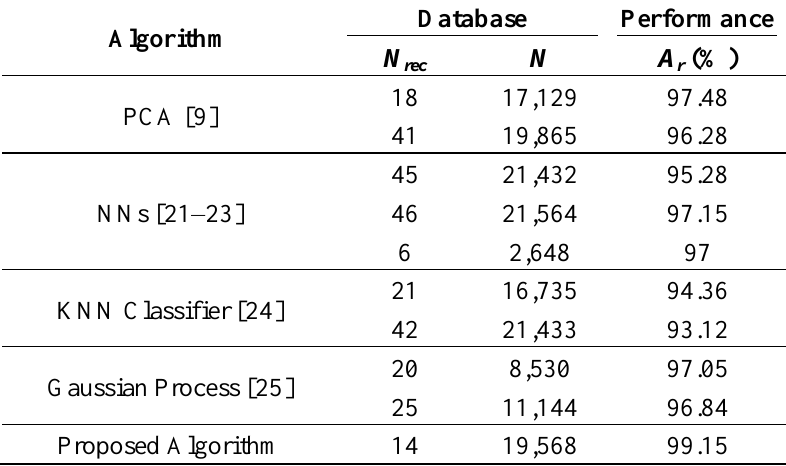
Table 3. Performance comparison among ECG signal feature extraction methods.